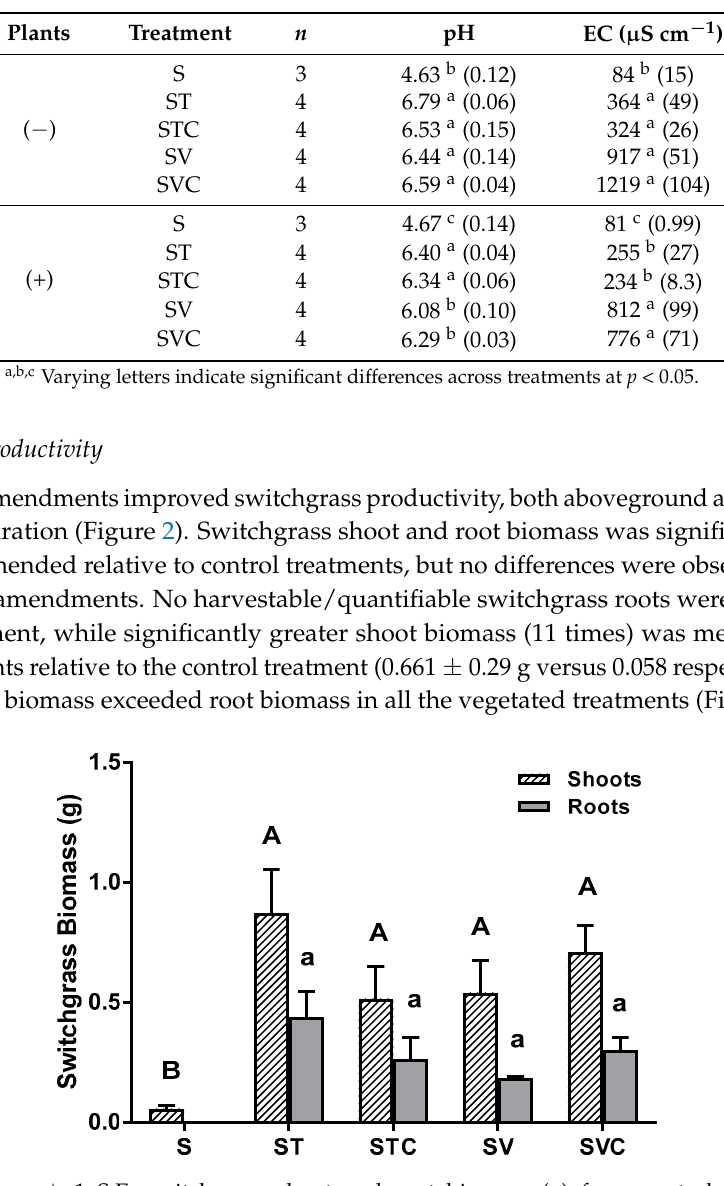
Figure 2. Mean ± 1 S.E. switchgrass shoot and root biomass (g) from control soil (S), and soil amended with thermophilic (T) and vermicompost (V) with and without coir (C). Varying uppercase and lowercase letters indicate significant differences in shoot and root biomass, respectively, across treatments.